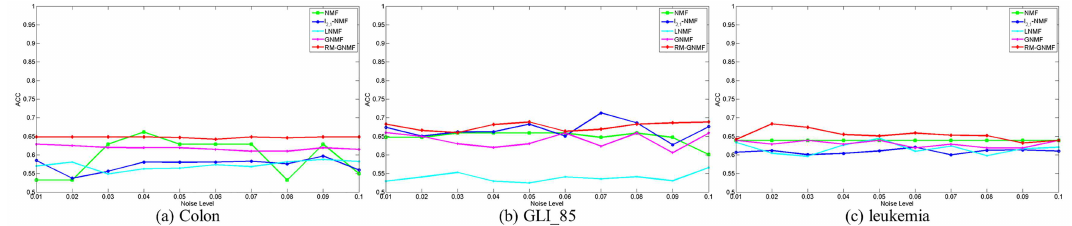
Figure 3. Influence of noise on clustering accuracy.